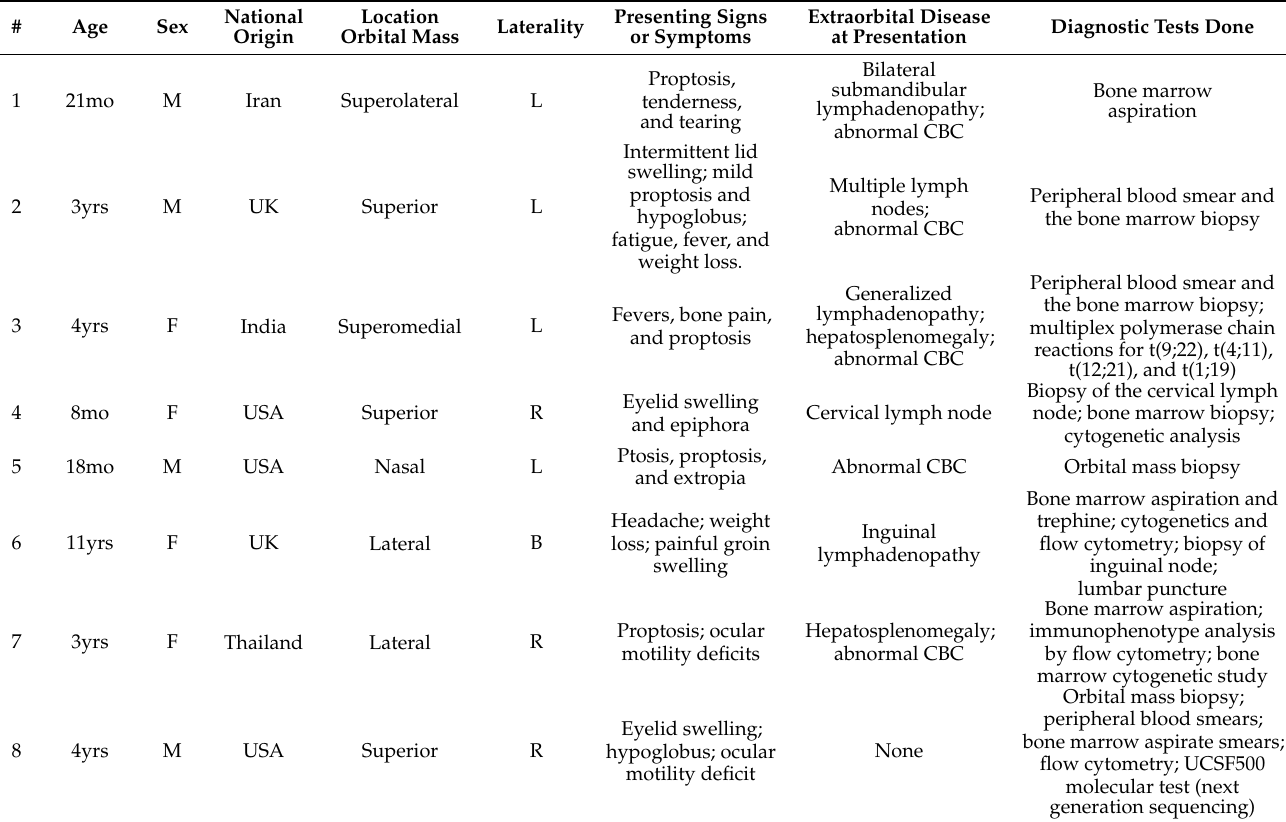
Table 1. Clinical characteristics of previous reported ALL cases with orbital involvement at the time of diagnosis